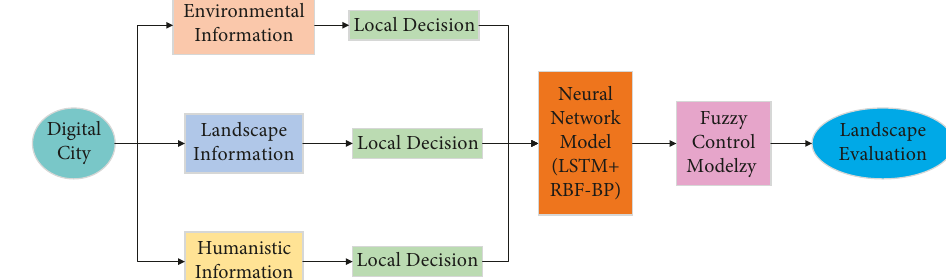
Figure 3: Information fusion model.